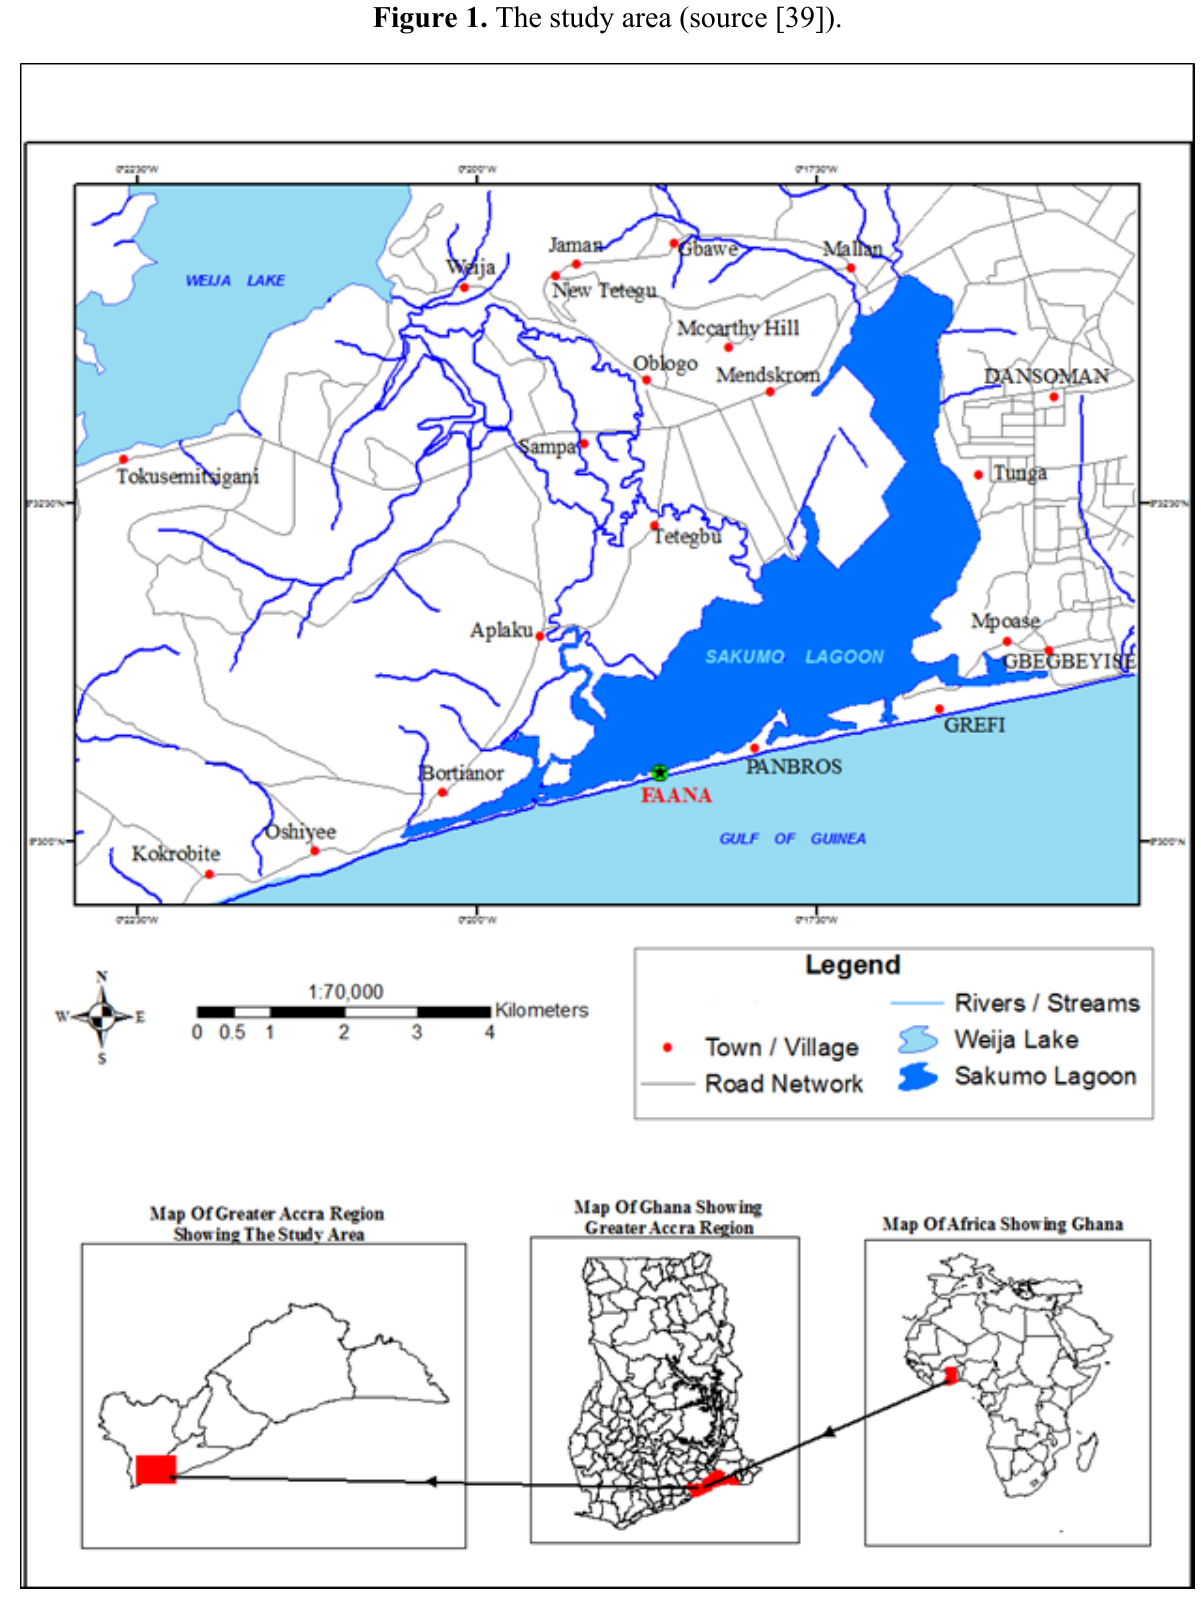
Figure 1. The study area (source